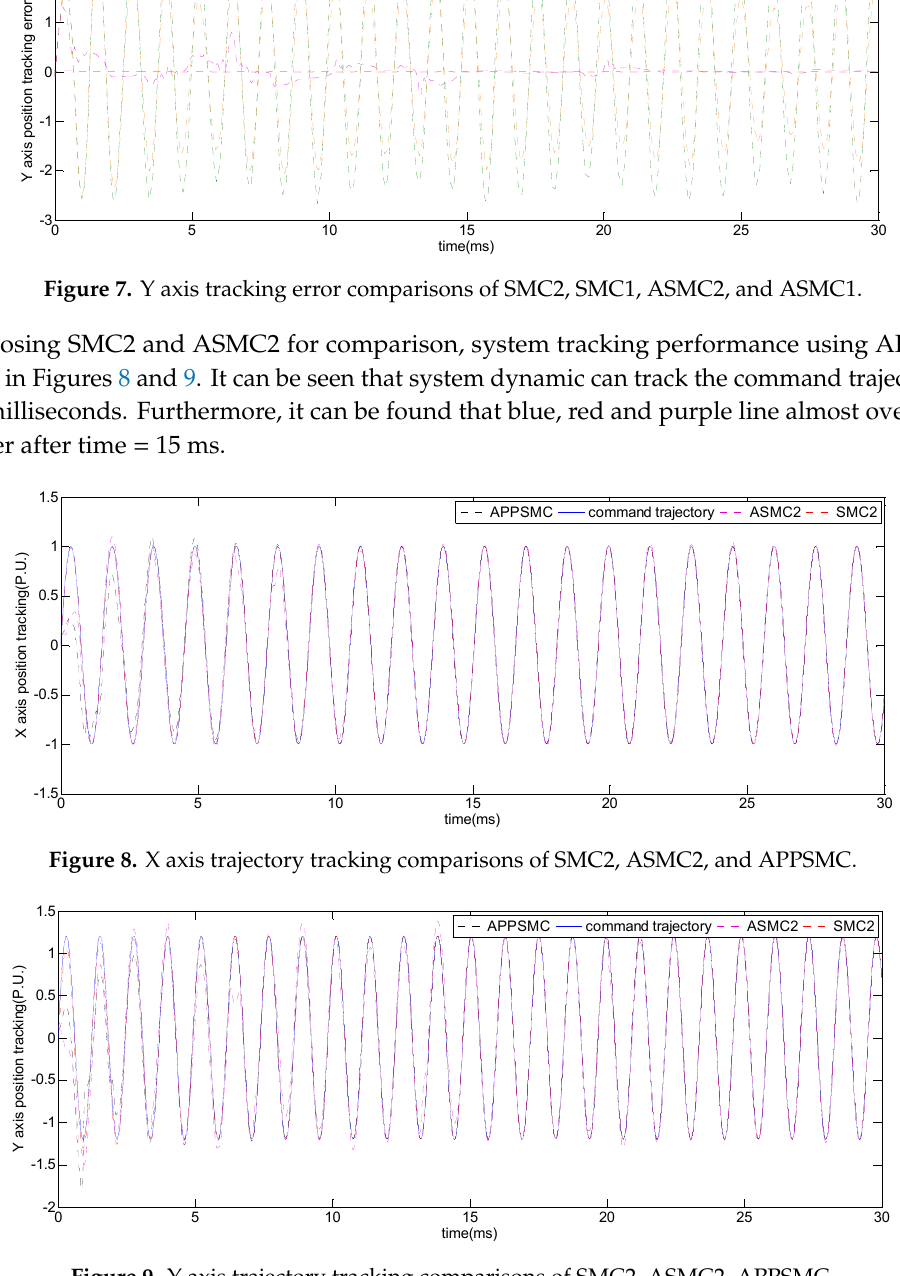
Figure 9. Y axis trajectory tracking comparisons of SMC2, ASMC2, APPSMC.